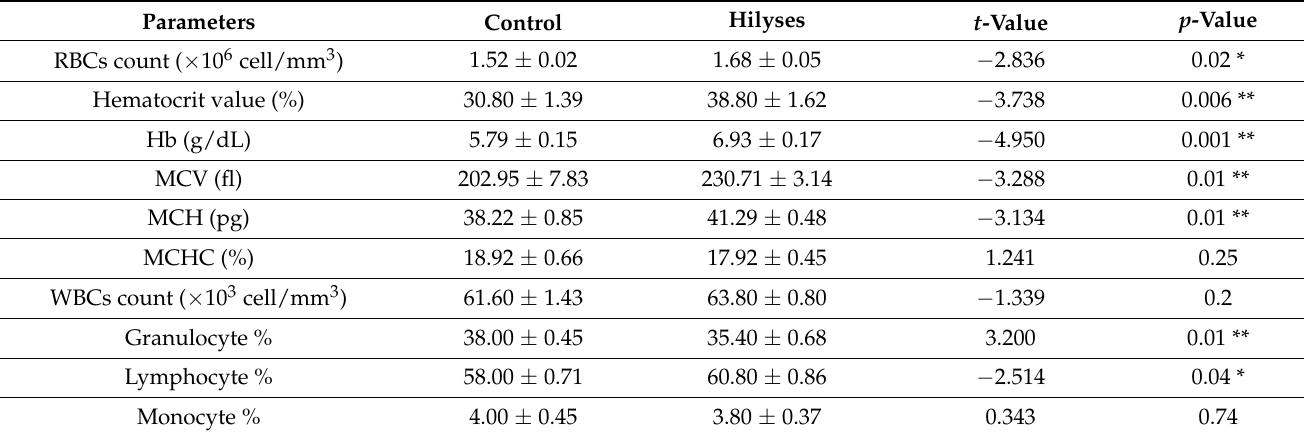
Table 4. Hematological parameters of Nile tilapia broodstock fed Hilyses and the control diets.